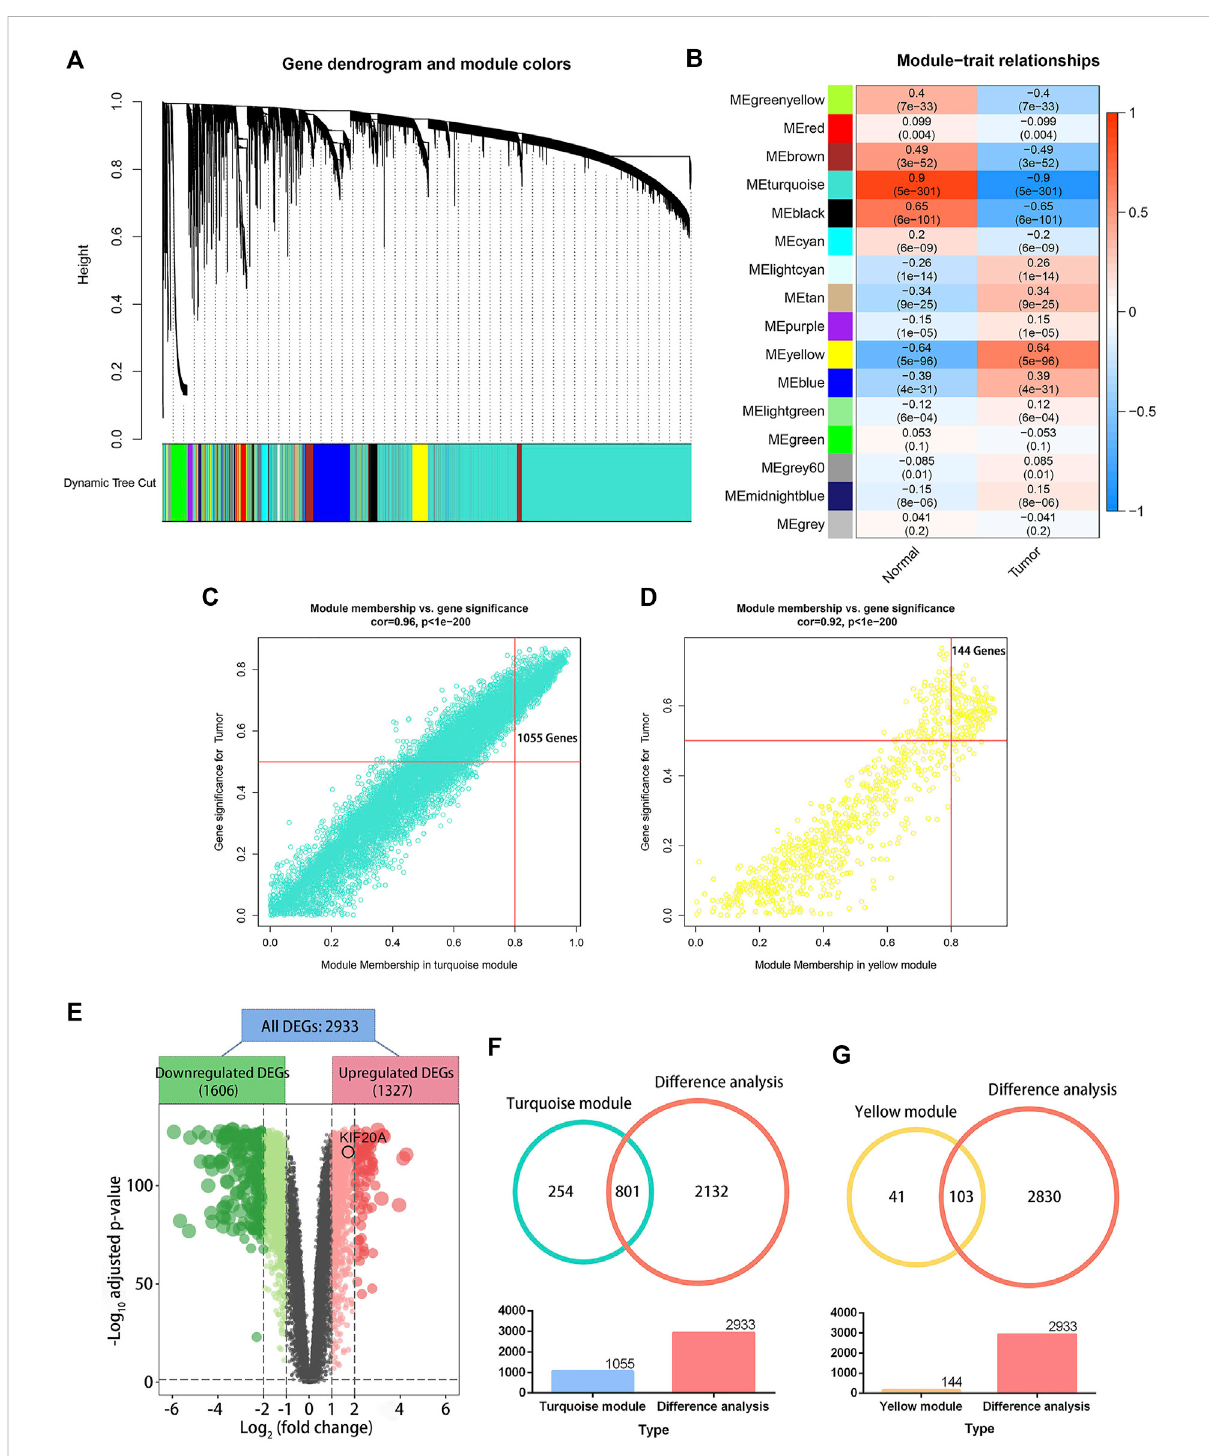
FIGURE 2 Weighted gene co-expression network analysis (WGCNA) and differential analysis. Image (A) illustrates a clustering dendrogram for the GTEx andTCGAdatasetsbasedonthedissimilaritymeasure(1-TOM).Heatmap (B) showsthecorrelationbetweenmoduleeigengenesandclinicaltraitsin LUAD. The scatter plots illustrate the eigengenes for the turquoise (C) and yellow (D) modules. A module membership above 0.8 and a gene signi fi cance greater than 0.5 were considered statistically signi fi cant. The volcano plot (E) shows 2,933 differentially expressed genes (DEGs) in LUAD samples versus normal lung tissues. An adjusted p -value < 0.05 and |log 2 (fold change)| > 1 were set as the cutoff criterion. The Venn plots (F) illustrate 801 genes overlapped by the turquoise module eigengenes and differential analysis, and the 103 genes were codetermined by the yellow module eigengenes and differential analysis (G)